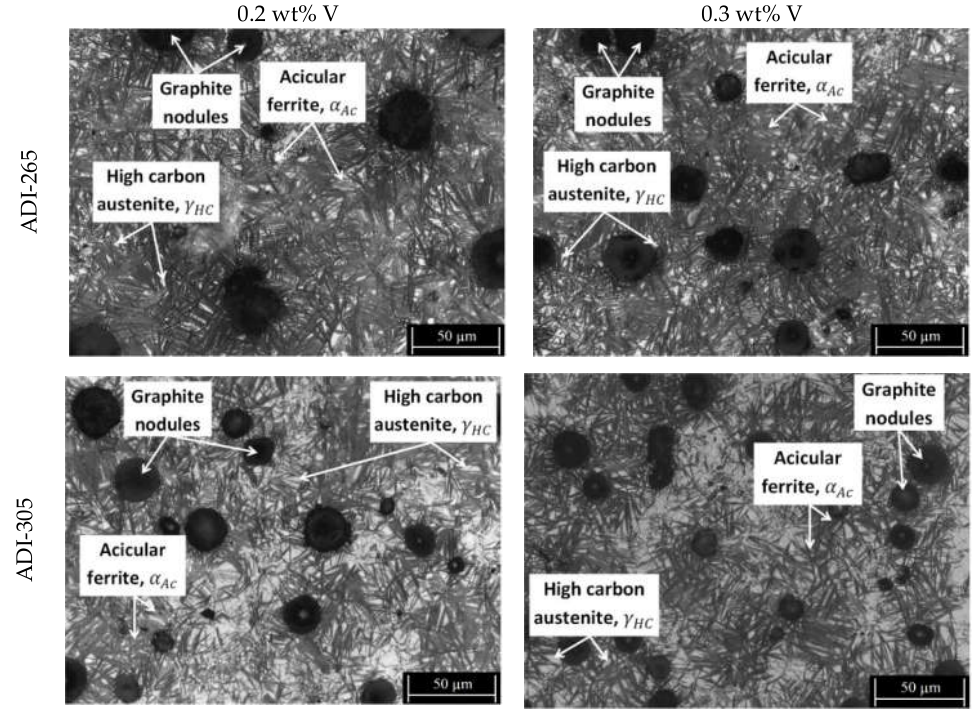
Figure 7. Microstructure of ADI alloyed with 0.2 wt% V heat-treated to 265 °C and 305 °C for 90 min.